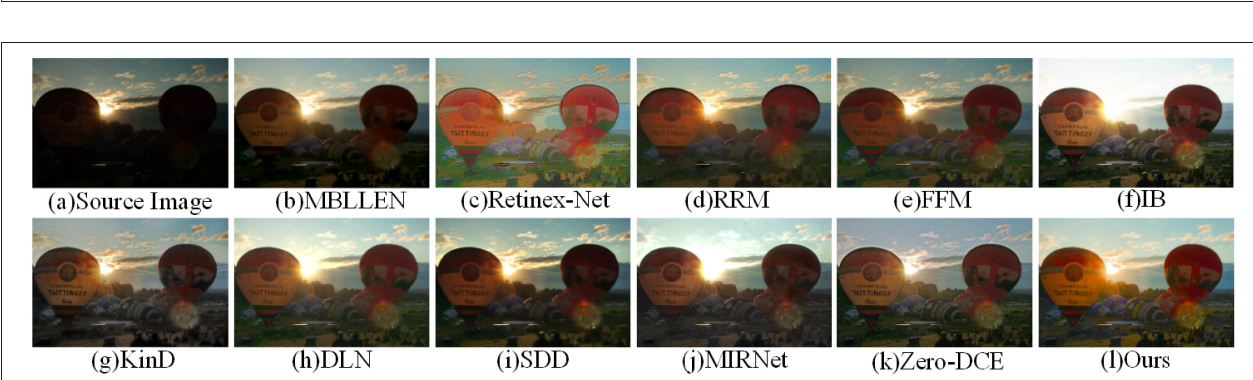
non-referenced quality evaluation indicators, respect-ively.